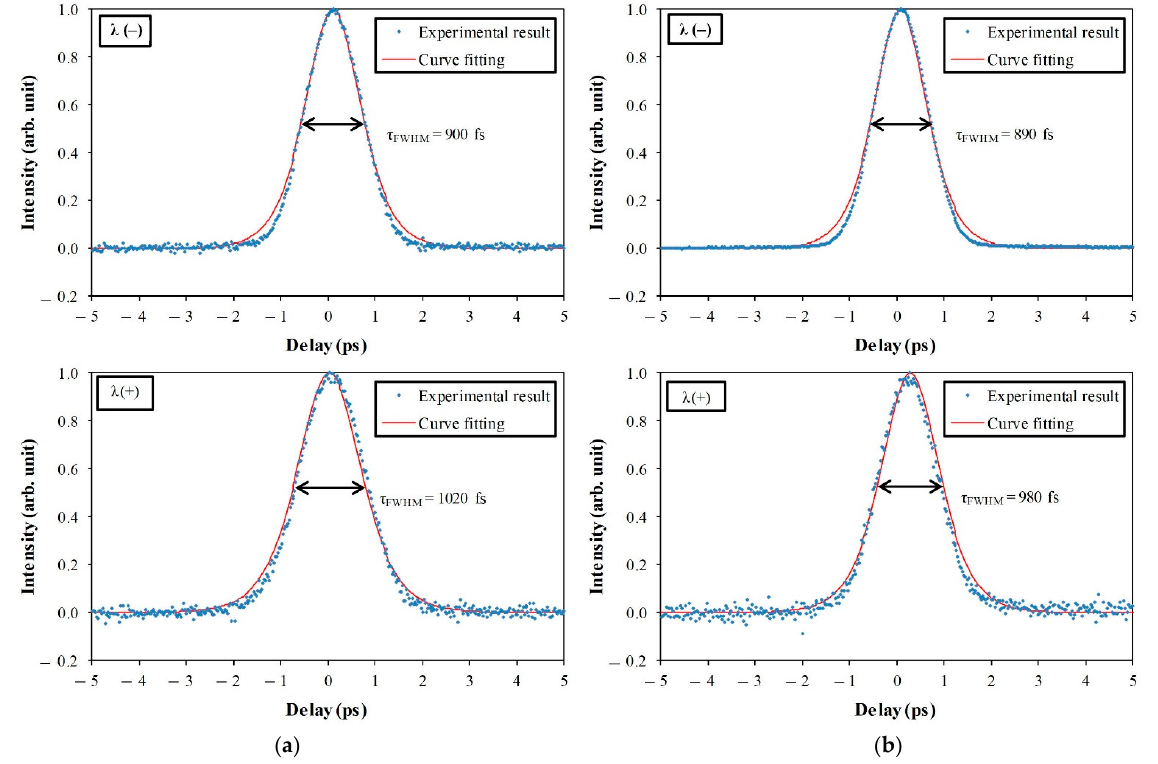
Figure 5. Autocorrelation trace for ( a ) unidirectional DWML-EDFL and ( b ) bidirectional DWML-EDFL at maximum pump power of 105.2 mW. The mode-locked pulse train for each cavity loop is measured using an oscilloscope (Tektronix TDS 3012C) together with a 5 GHz In GaAs-biased photodetector (Thorlabs, DET08CFC, Newton, United States). The results are shown in Figure 6 a, b, correspond- ing to unidirectional and bidirectional DWML-EDFL, respectively. Since the total cavity length of all the cavity loops is almost similar, about 17 m, the pulse repetition rate for each cavity loop does not vary much between one another, with the values ranging from 9.22 MHz to 9.29 MHz. The evenly spaced pulse interval between the consecutive pulses validates the good stability of the pulse output.